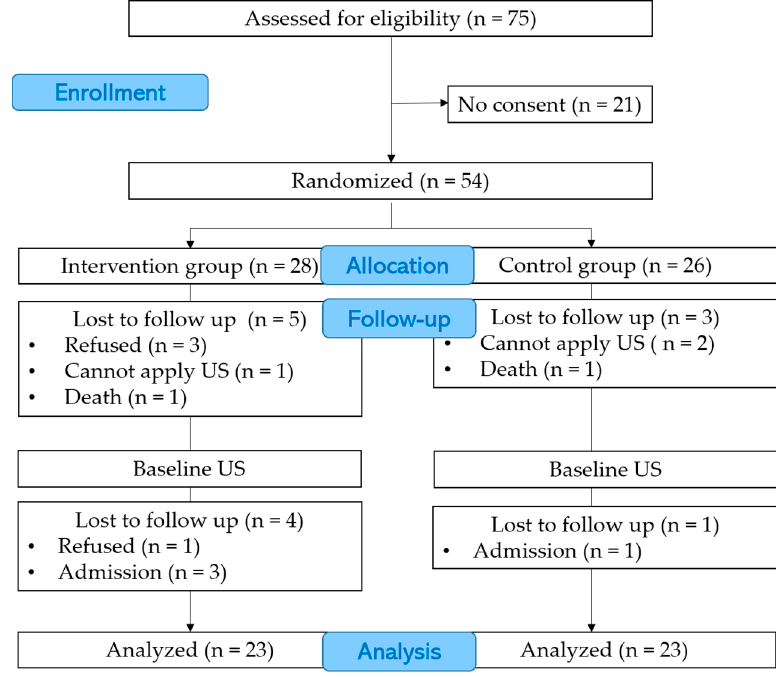
Figure 2. Participants Consort flow diagram. US: Ultrasound.